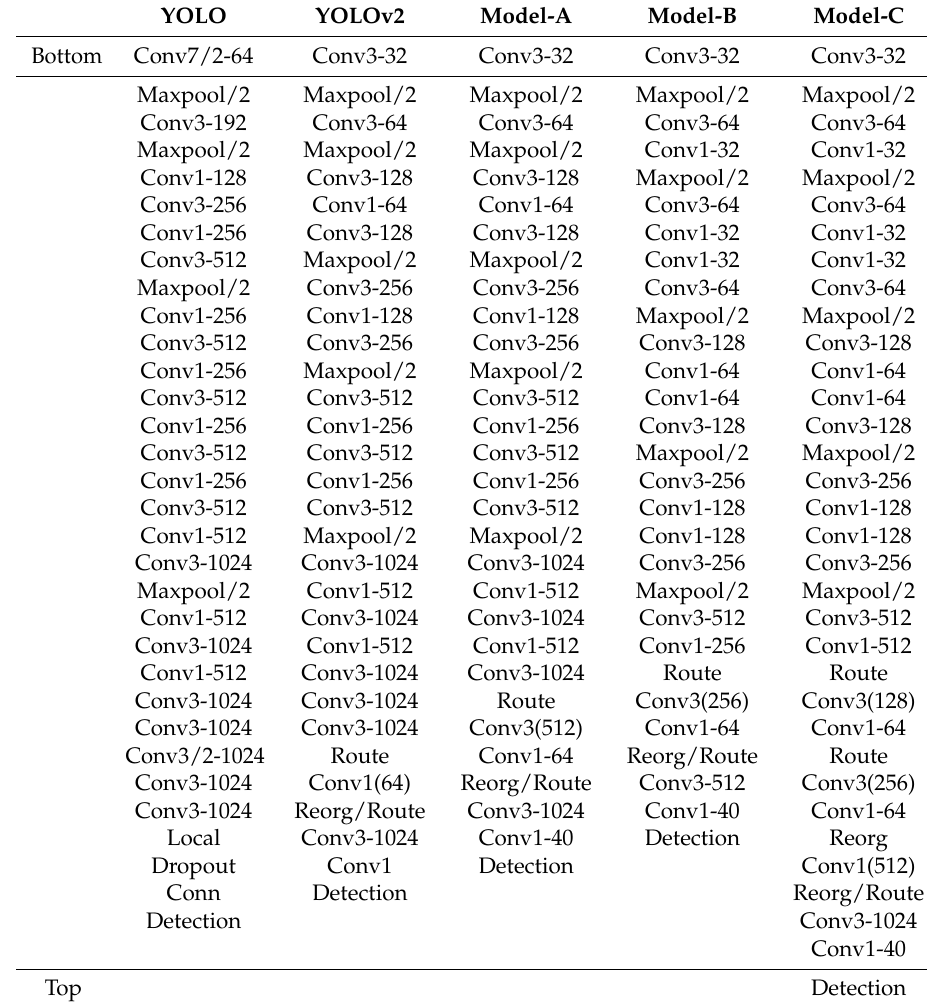
Table 1. ConvNet